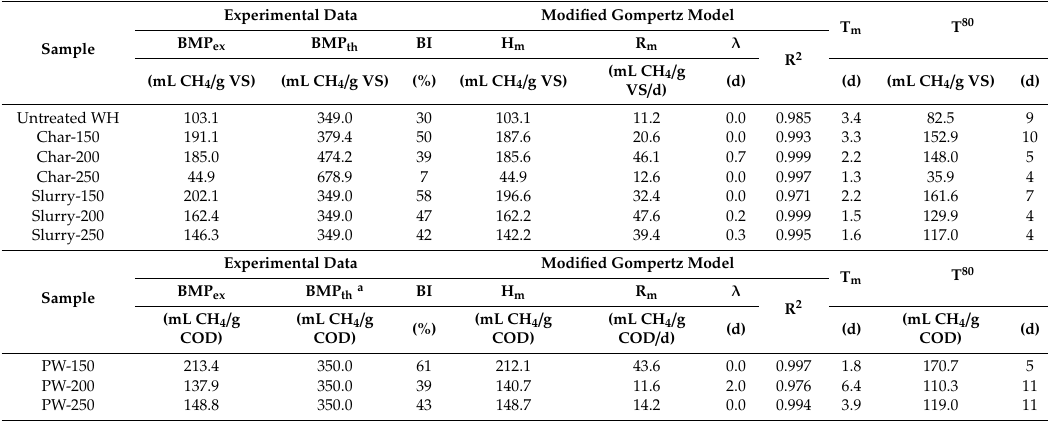
Table 6. Digestion kinetics from the anaerobic digestion of untreated water hyacinth (WH) and hydrothermal products. Experimental Data Sample Untreated WH